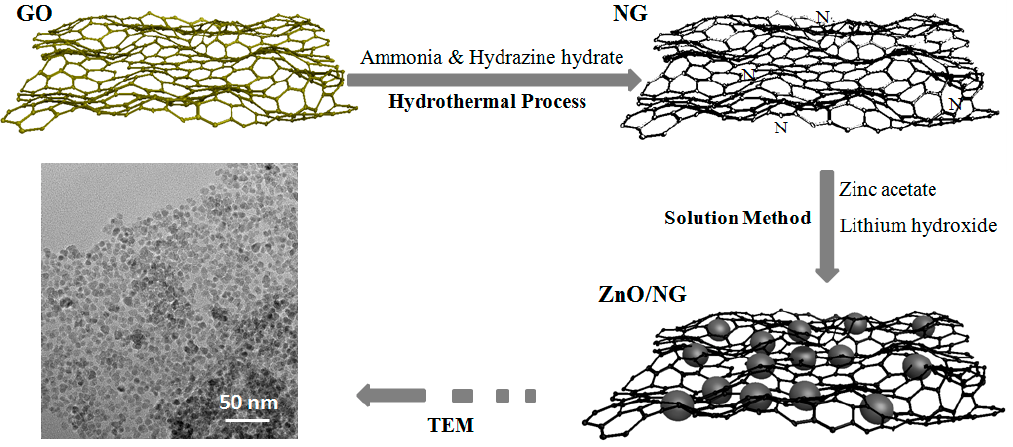
Figure 7. The preparation of the ZnO/NG composite.